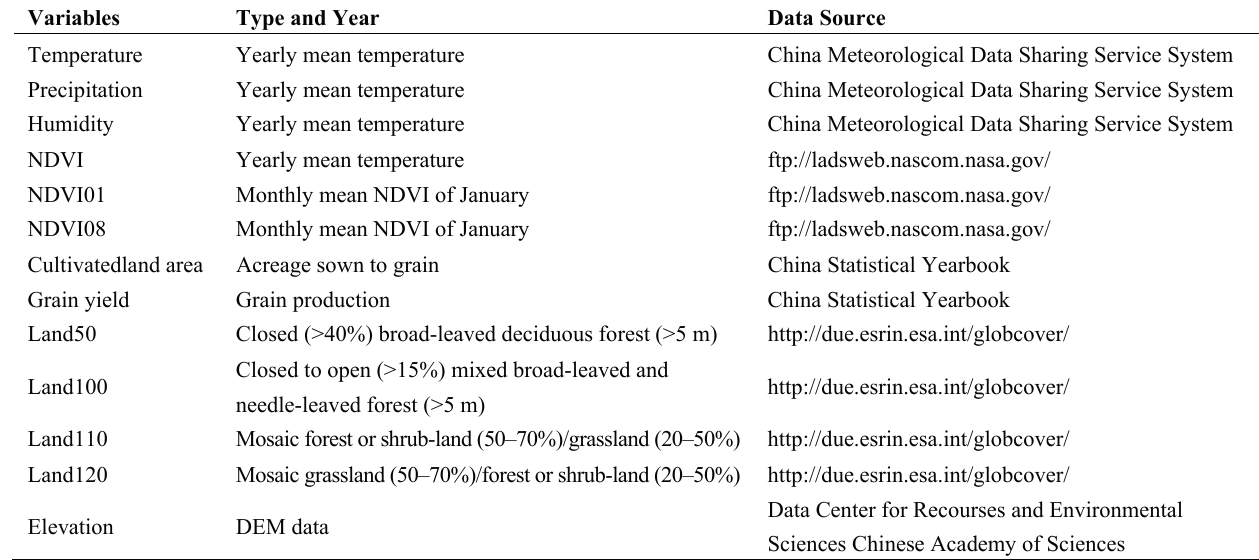
Table 1. List of variables used in the HFRS incidence analysis in China, 2005 to